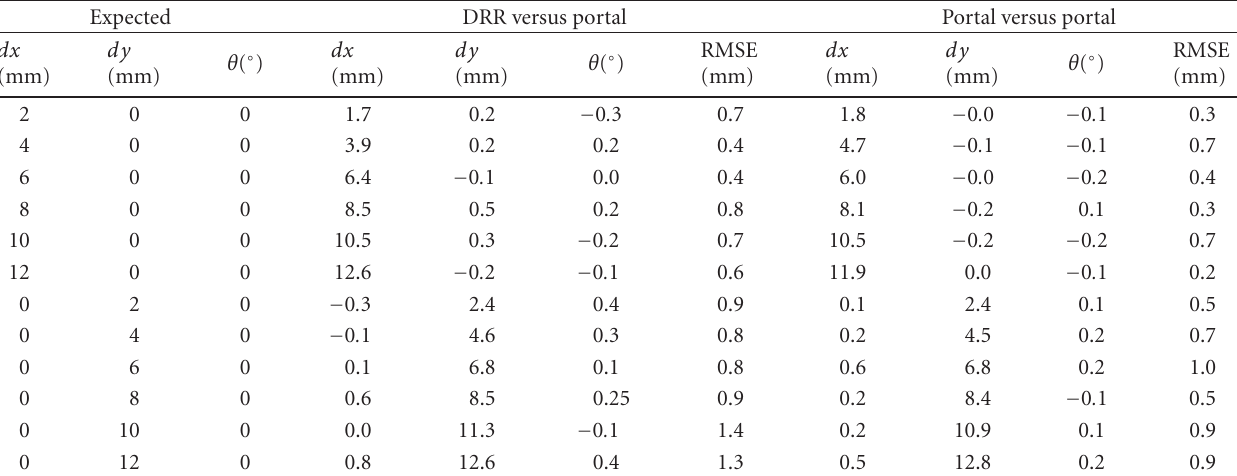
Table 2: Setup error estimations (horizontal displacement, vertical displacement, angle of rotation, and RMS error) for known setup error of the cranial region of the phantom for DRR versus portal and portal versus